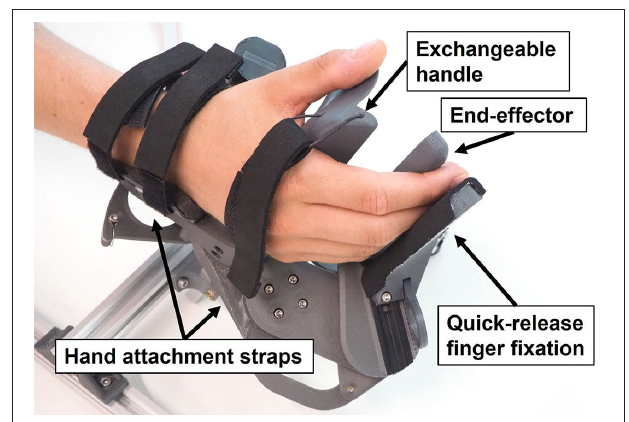
FIGURE 1 | Prototype of the clinical-driven Palmar RehabilitatIon DEvice